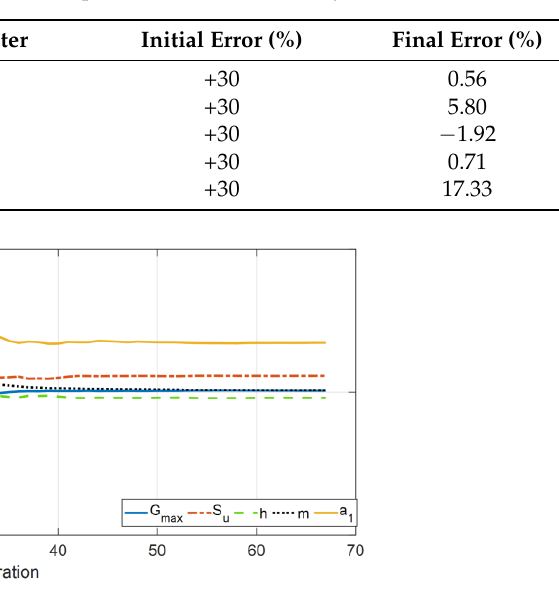
Figure 9. Identified parameters in Case Study 3 (normalized by the corresponding true values).